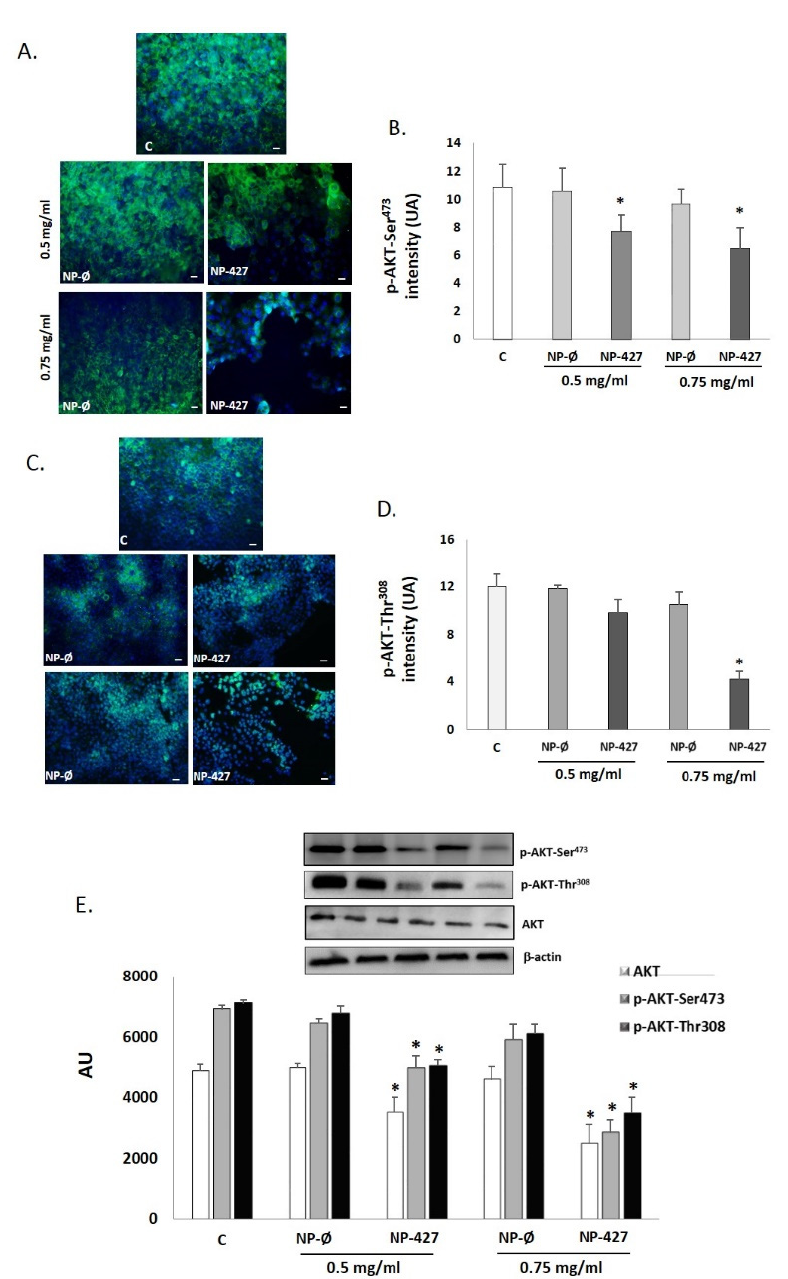
Figure 8. AKT levels decrease with the treatment of nanoparticles loaded with PHT-427 on FaDu cells. Representative fluorescence micrographs of the immunostaining of p-AKT-Ser 473 (green fluorescence) ( A ) and p-AKT-Thr 308 (green fluorescence) ( C ) in FaDu cultures treated with C (control), NP-Ø (unloaded NPs, 0.5 and 0.75 mg/mL), and NP-427 (PHT427-loaded NPs, 0.5 and 0.75 mg/mL) for 24 h. The nuclei were identified in blue fluorescence by DAPI. Scale bar: 100 µ m. The images were taken at random in a blinded fashion. ( B , D ) ImageJ quantifies fluorescence intensity for p-AKT-Ser 473 ( B ) and p-AKT-Thr 308 ( D ). The values represent the mean ± SD arbitrary units (AU) in triplicate. * p < 0.05 versus control and NP-Ø groups ( n = 4). ( E ) p-AKT-Thr 308 , p-AKT-Ser473, and total AKT protein levels were analyzed by Western blotting in FaDu cells protein extracts from the different treatment group. A representative Western blot and densitometry analysis for each protein are shown. β -actin was used as a loading control. The diagrams represent the mean ± SD of arbitrary units (AU). * p < 0.05 vs. control and NP-Ø groups ( n = 4).